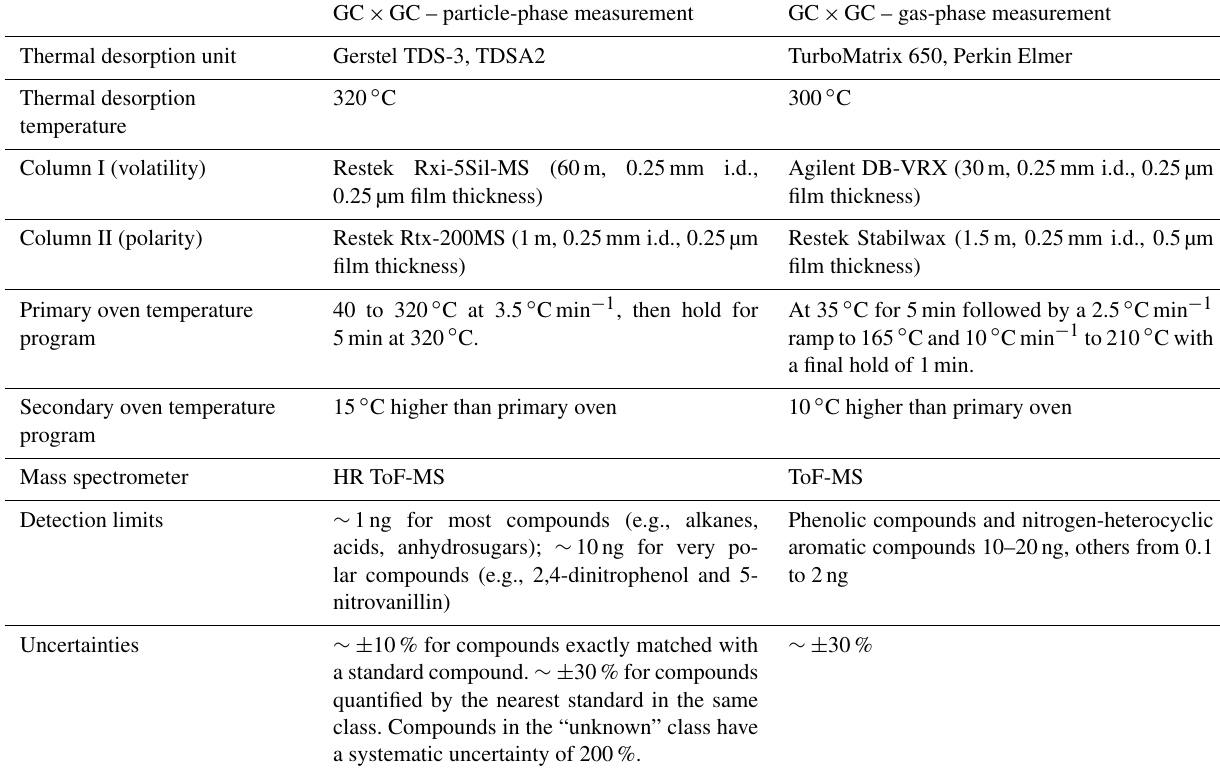
Table 2. GC × GC materials and methods GC × GC – particle-phase